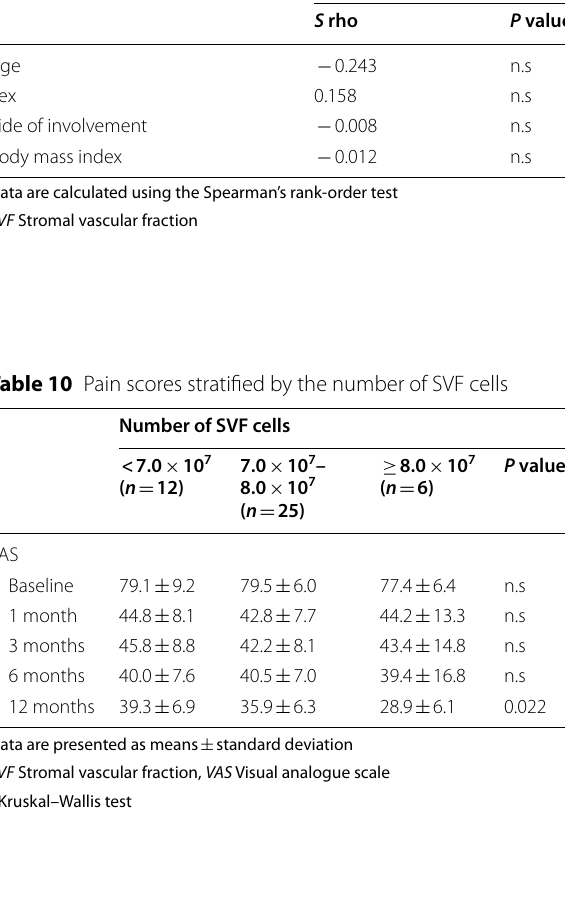
Table 9 Patient characteristics and SVF correlations Patient Characteristics